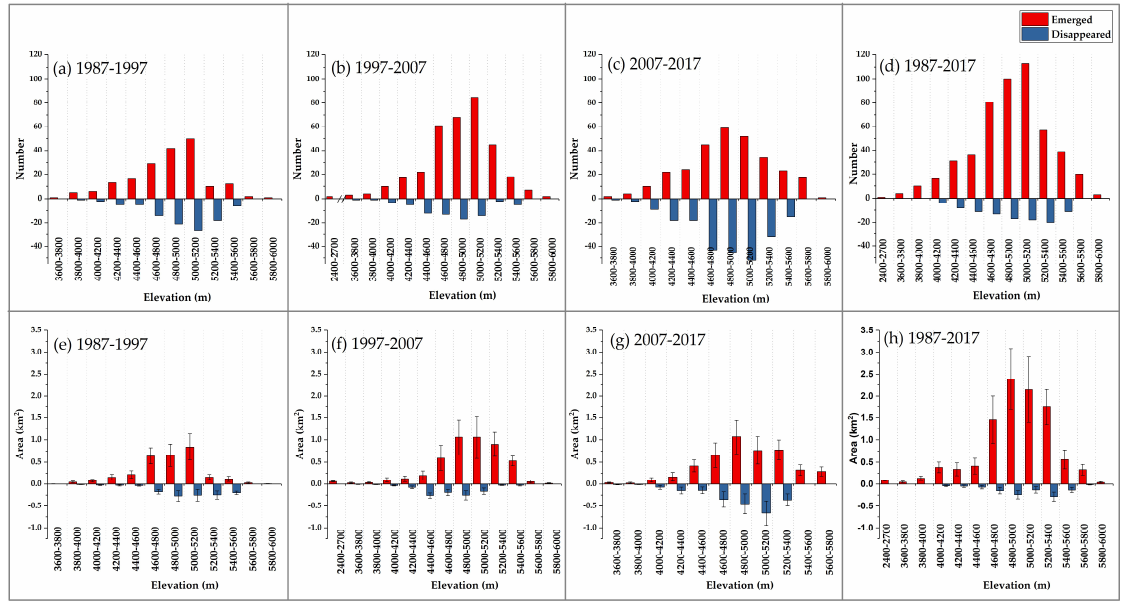
Figure 9. Frequency distribution of newly emergent and disappeared glacial lakes at 200 m elevation band in ( a ) 1987–1997, ( b ) 1997–2007, and ( c ) 2007-2017. Similarly, the sum of the surface area gain or loss by glacial lakes is shown in each elevation band for ( e ) 1987–1997, ( f ) 1997–2007, and ( g ) 2007–2017. The overall changes in the total number ( d ) and surface area ( h ) of emerged and disappeared glacial lakes in the overall period of 1987–2017. Emergent lakes are those lakes that were formed between the respective periods and existed in the last year of the period. Disappeared lakes are those lakes that perished in the period and did not exist in the last year of the period.